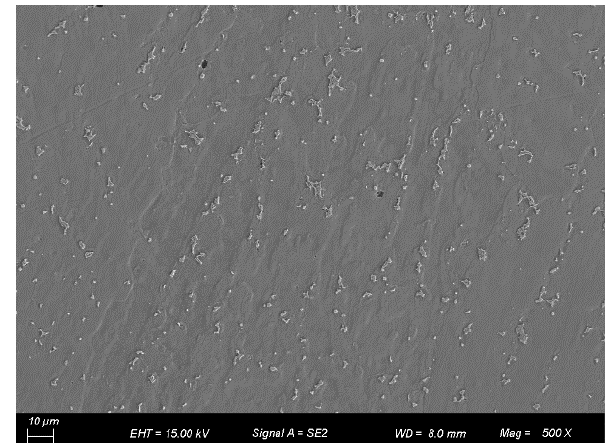
Figure 17. Inspection results of the weld